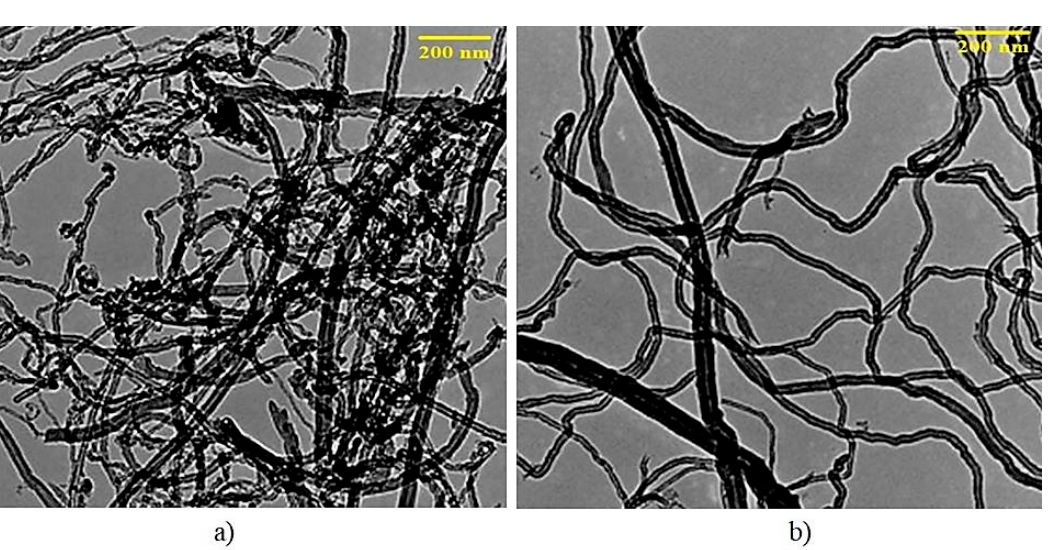
Figure 4. TEM photos of ( a ) pristine MWCNTs and ( b ) APTES-treated MWCNTs.